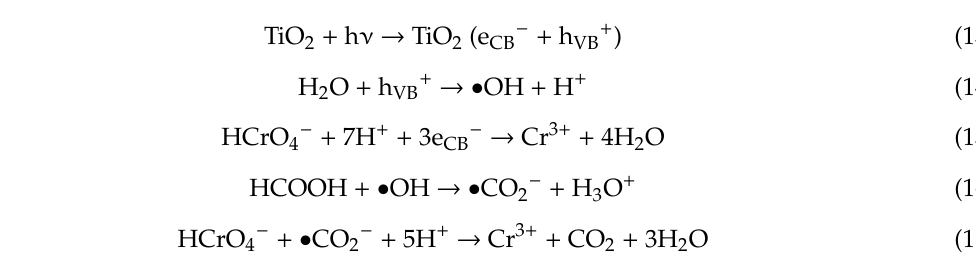
Figure 7. Reaction mechanism for the photocatalytic reduction of Cr(VI) with TiO 2 in the presence of formic acid.